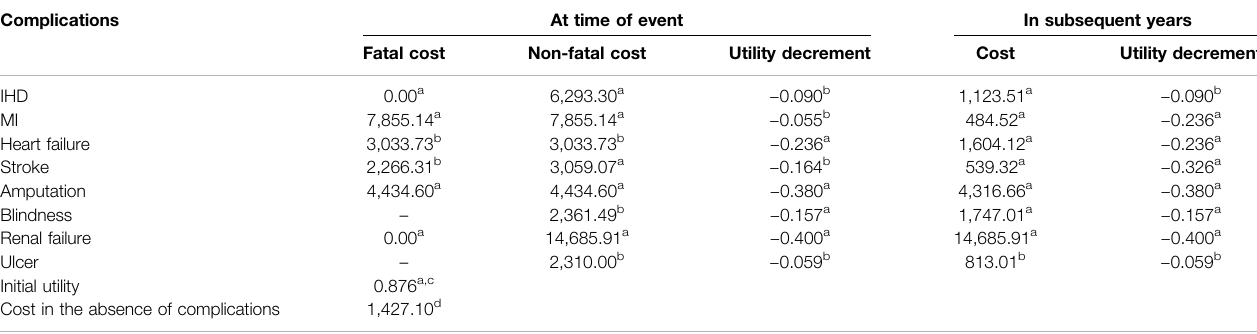
TABLE 3 | Key model inputs of costs and utilities.